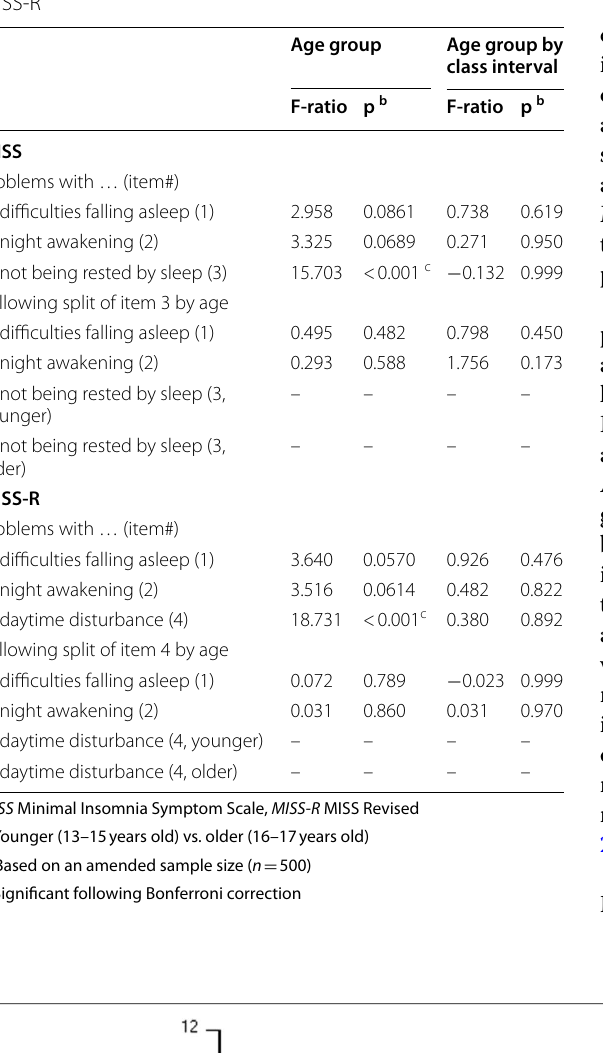
more insomnia) and their corresponding linear logit = 1226) and older ( n 1375) = =